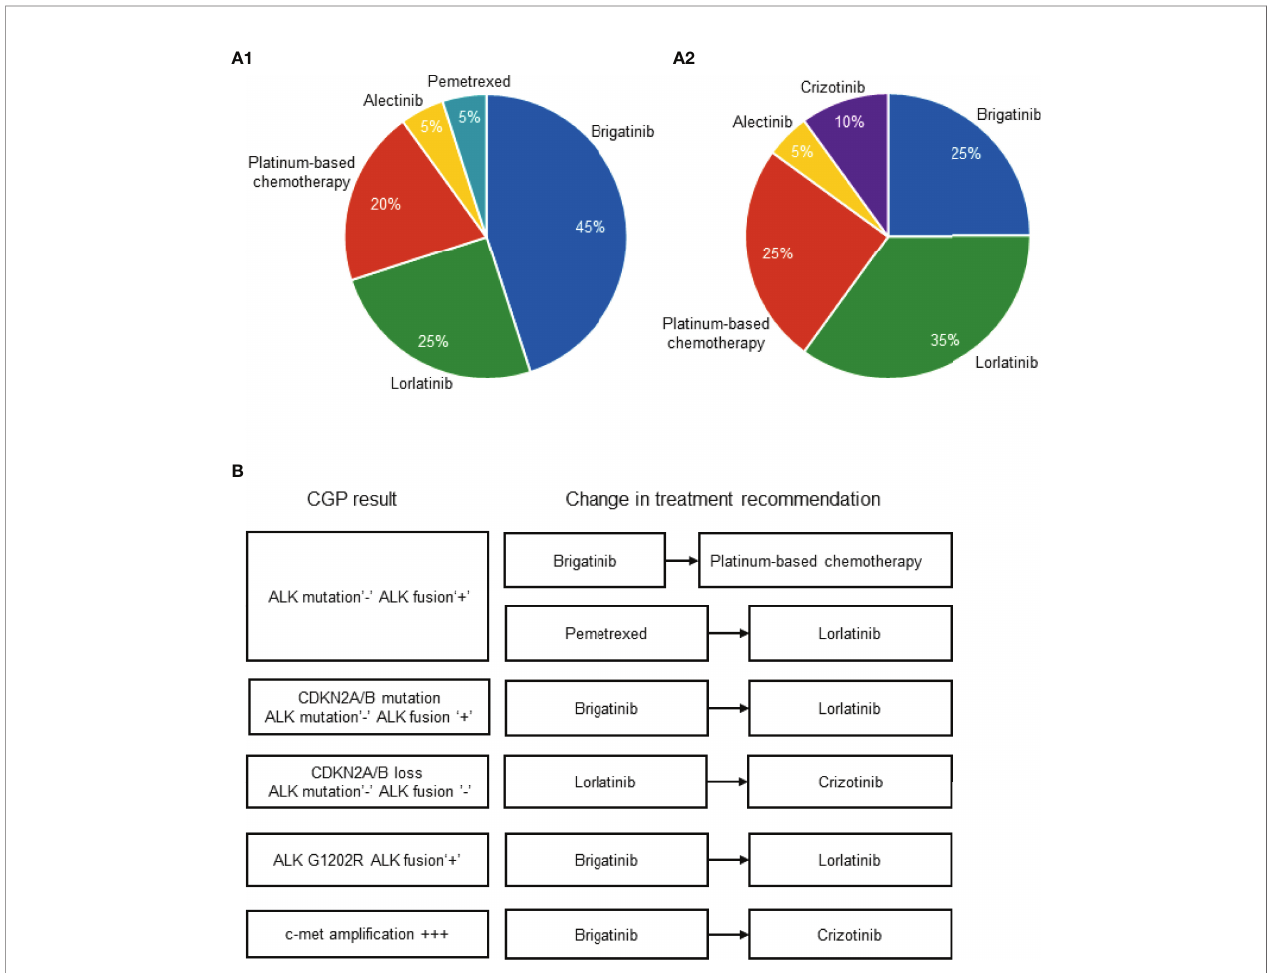
FIGURE 2 | Physician ’ s choice of the most recommended NLST captured before (A1) and after (A2) the receival of CGP results. Change in treatment recommendation upon the receival of CGP results (B) . ALK, anaplastic lymphoma kinase; CDKN2A/B, cyclin dependent kinase inhibitor 2A/B; CGP, comprehensive genomic pro fi ling; c-met, tyrosine-protein kinase Met; NLST, next-line systemic